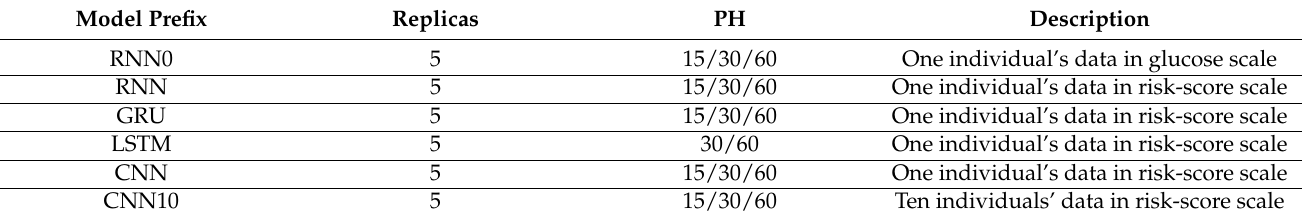
Table 1. Model prefix and the corresponding description. Several replicas per model per prediction horizon (PH) were trained. Models were named as Model prefix _ number . The model prefix defines the architecture, the training set, and the training scale used.